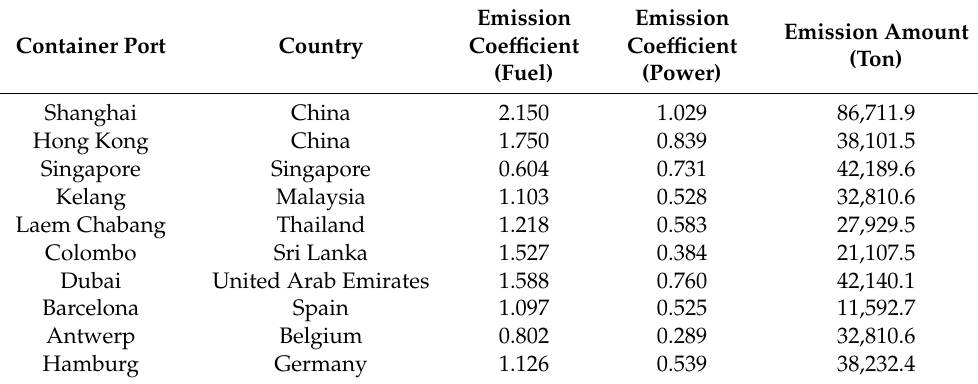
Table 3. CO 2 emissions of the 10 container ports along the MSR.